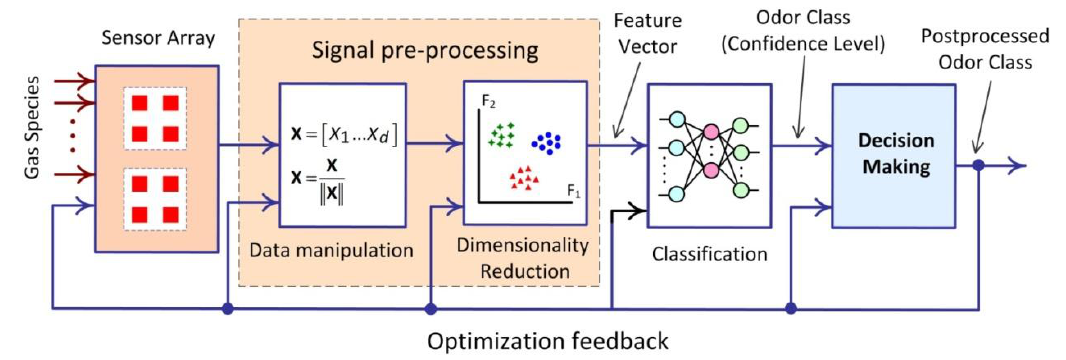
Figure 1. Building blocks of the pattern analysis system for an